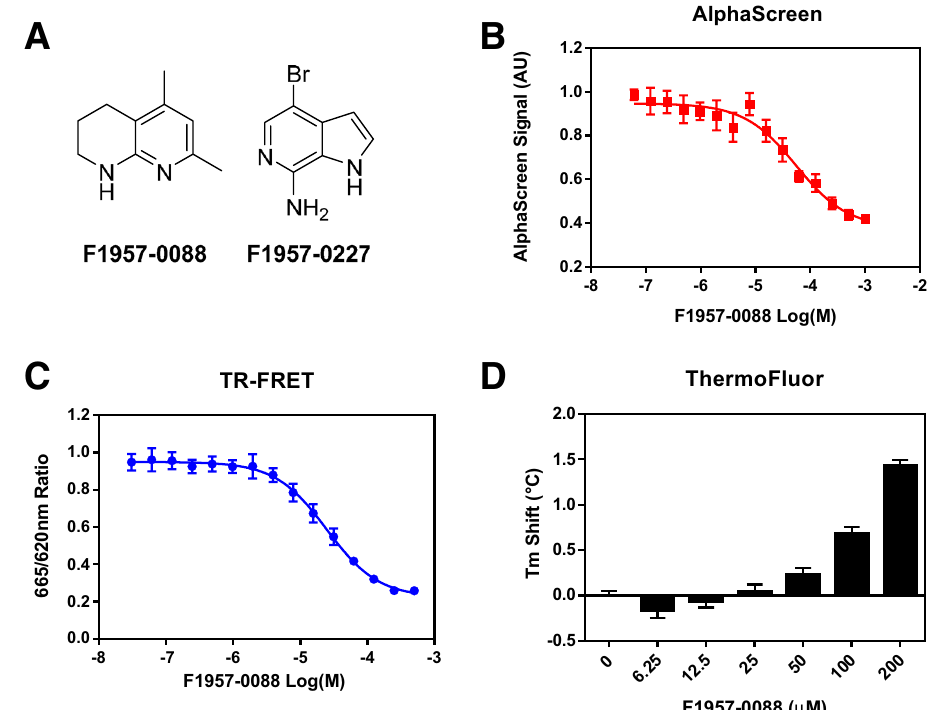
Figure 2. A fragment hit (F1957-0088) dose-dependently targets TTD in three parallel assays. ( A ) Chemical structures of two fragment hits that overlapped in all three screening methods. ( B ) F1957-0088 dose- dependently inhibited N-UHRF1 interaction with C-UHRF1 using AlphaScreen assay. ( C ) F1957-0088 dose-dependently inhibited His-TTD binding to H3K9me3 peptide in TR-FRET assay. ( D ) F1957-0088 dose-dependently increased the melting temperature (Tm) of His-TTD using the TSA. n = 3 for AlphaScreen, TR-FRET, and TSA and the error bars represent standard